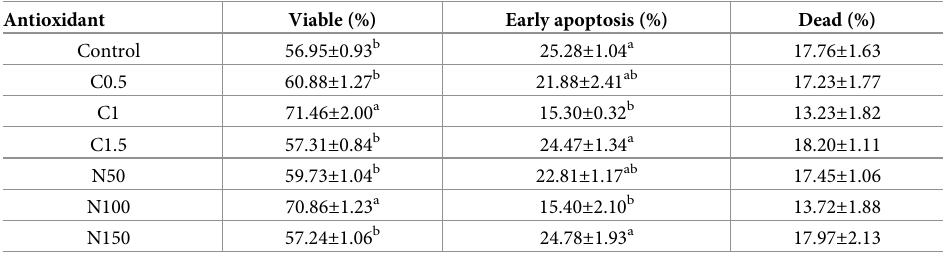
Table 5. Effect of different levels of crocin and naringenin on viable, apoptotic and dead sperm in rooster thawed semen, as assessed by flow cytometry ( n = 5).